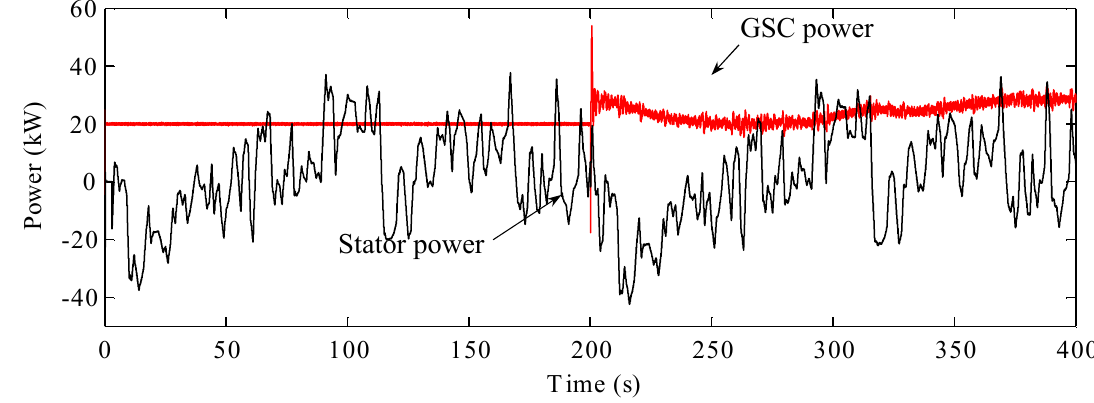
Figure 14. Stator power and GSC power of the proposed FES